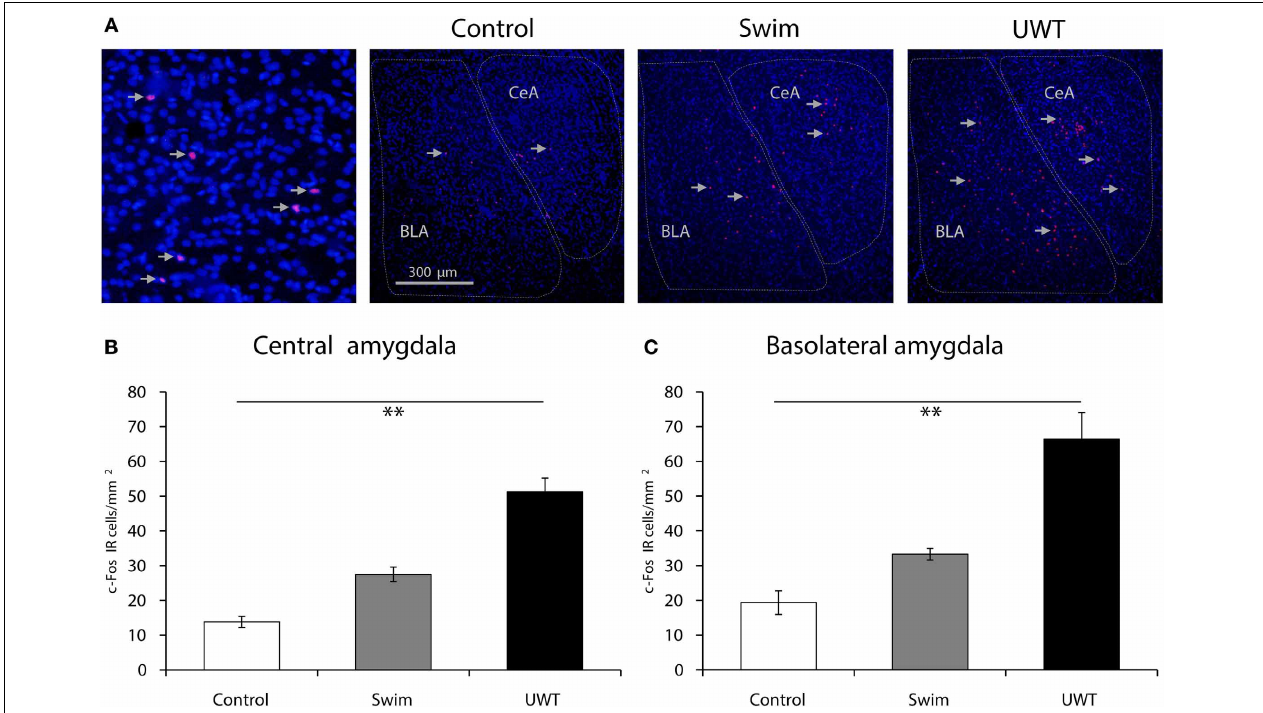
FIGURE 4 | c-Fos expression 90min after the WAZM test on the 30th day. (A) Representative images of c-Fos-IR (red) and DAPI (blue) in the central amygdala (CeA) and basolateral amygdala